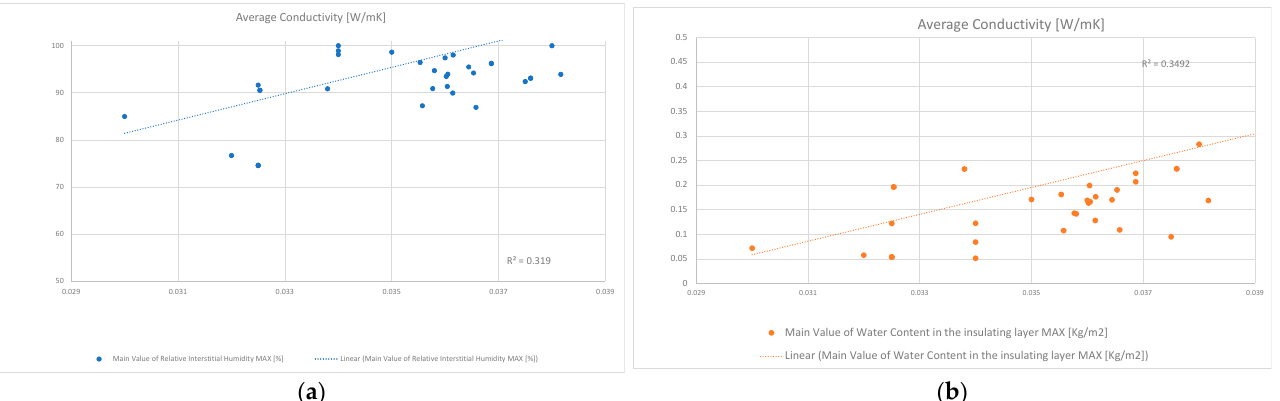
Figure 8. ( a ) Results of the conductivity values of the insulation as a function of the amount of IRH. ( b ) Results of the conductivity values of the insulation as a function of the amount of WCI.